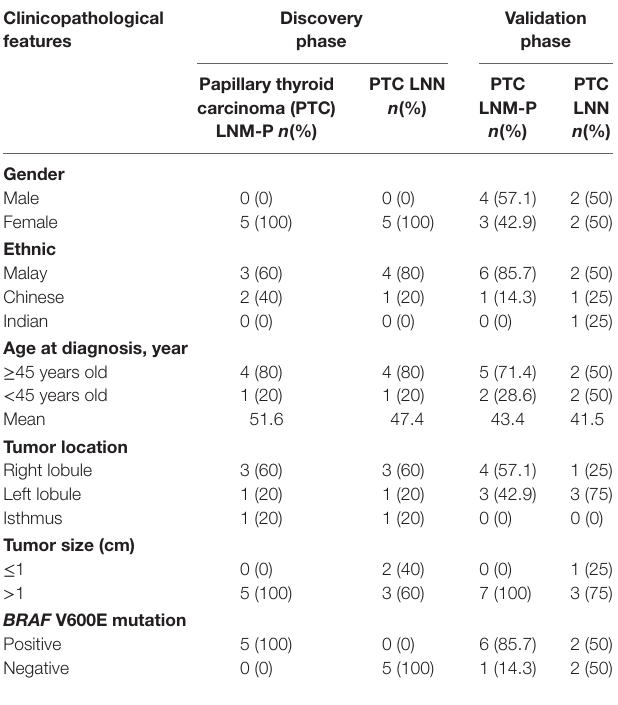
TaBle 1 | Clinicopathological features of patients in discovery and validation